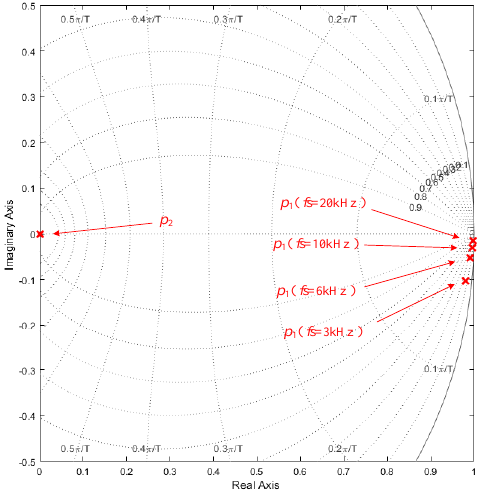
Figure 6. The location of the poles for the closed-loop transfer function in Equation (23).